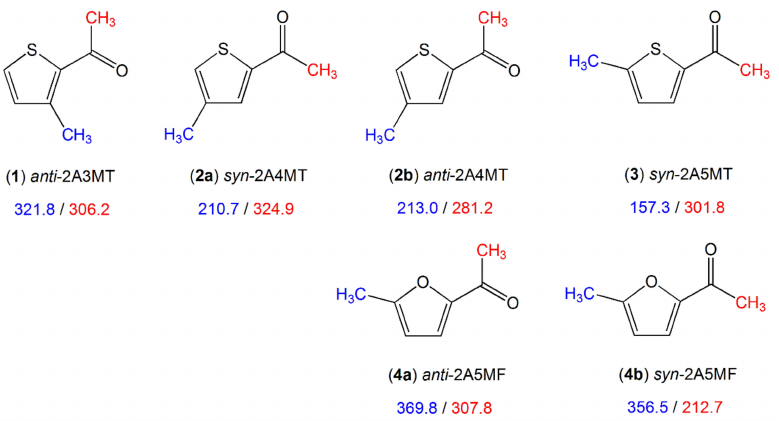
Figure 11. Barriers to methyl internal rotation in furan and thiophene derivatives with a methyl rotor on the ring and an acetyl group which contains another methyl rotor (in cm − 1